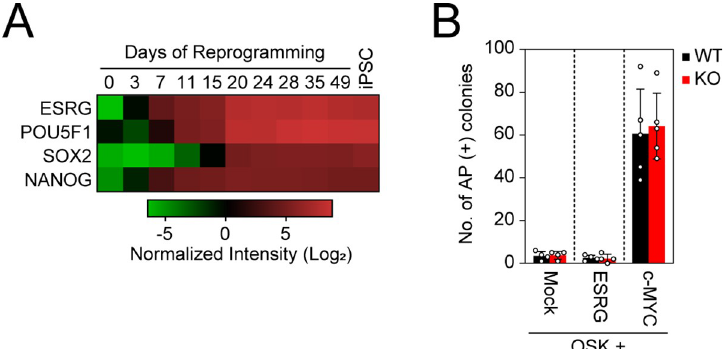
Fig 5. ESRG is dispensable for iPSC reprogramming. (A) The expression of ESRG during reprogramming. The heatmap generated by using the dataset (GSE54848) shows the normalized intensities of ESRG, POU5F1 (endogenous), SOX2 (endogenous), and NANOG expression from microarray data in the time course of iPSC reprogramming (days 0–49) and established iPSCs (far right). n = 3. (B) The effect of ESRG on iPSC generation. Shown are the numbers of AP (+) iPSC colonies 24 days after the transduction of OSK along with Mock (n = 4), ESRG (n = 4), and c-MYC (n = 5). Numerical values for A and B are available in S1 Data.